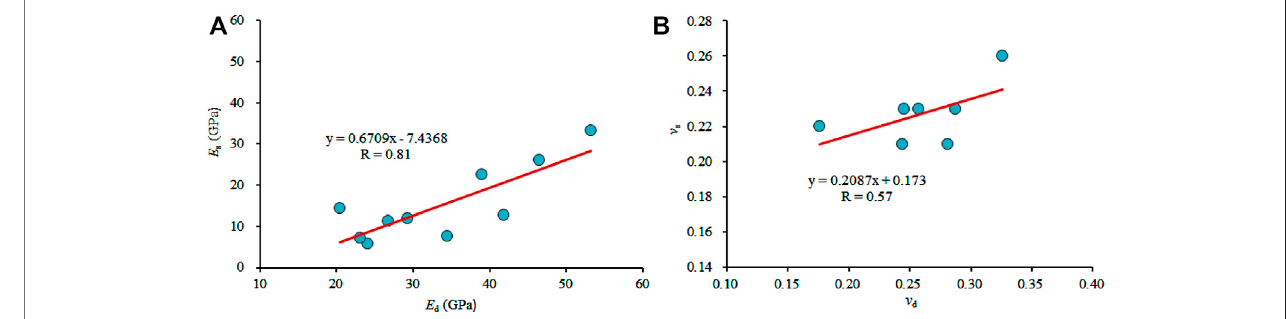
FIGURE 4 | The vertical distribution characteristics of each principal in- situ stress in the target layer of the study area.